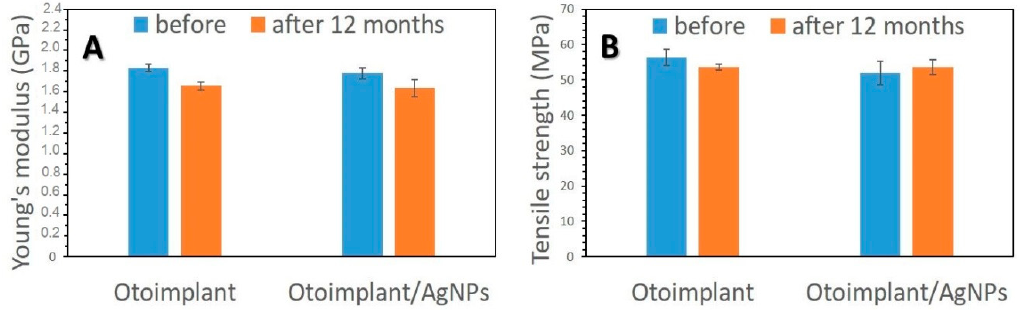
Figure 12. Young’s modulus ( A ) and tensile strength ( B ) of otoimplant and otoimplant/AgNPs before and after 12-month incubation in deionized water.